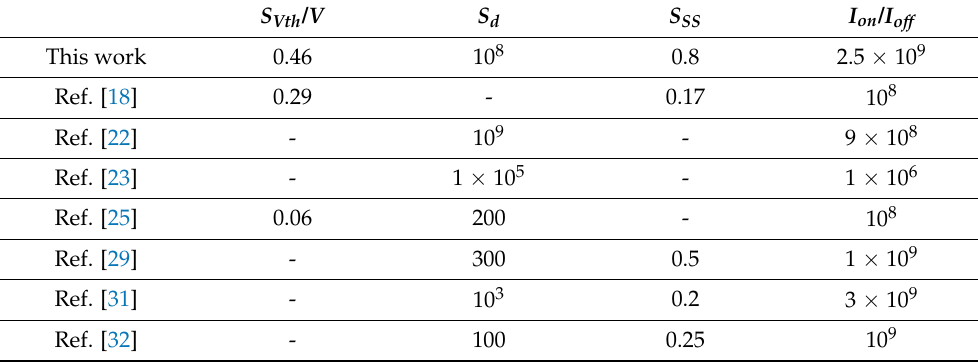
Table 2. Sensitivity comparison of the DM-SSTGTFET biosensor with other reported TFET